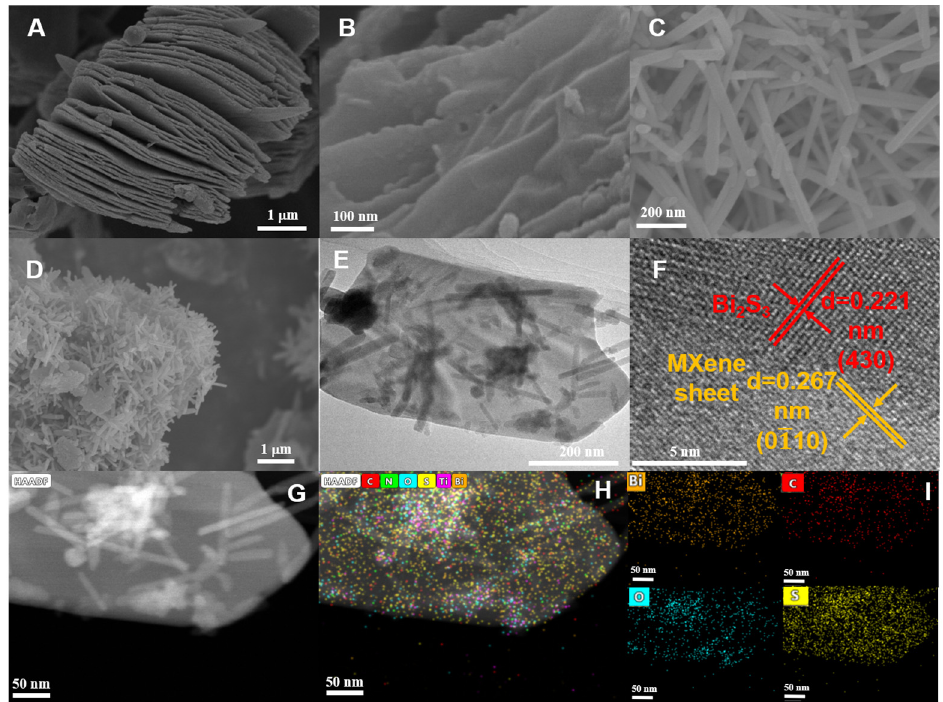
Figure 1. SEM images of ( A ) organ-like Ti 3 C 2 T X MXene; ( B ) Ti 3 C 2 T X MXene nanosheet; ( C ) Bi 2 S 3 and ( D ) Bi 2 S 3 /Ti 3 C 2 T X MXene nanosheet; ( E )TEM image of Bi 2 S 3 /Ti 3 C 2 T X MXene; ( F ) HRTEM images of Bi 2 S 3 /Ti 3 C 2 T X MXene; ( G ) HAADF image and ( H , I ) EDS mappings of Bi 2 S 3 /Ti 3 C 2 T X MXene.